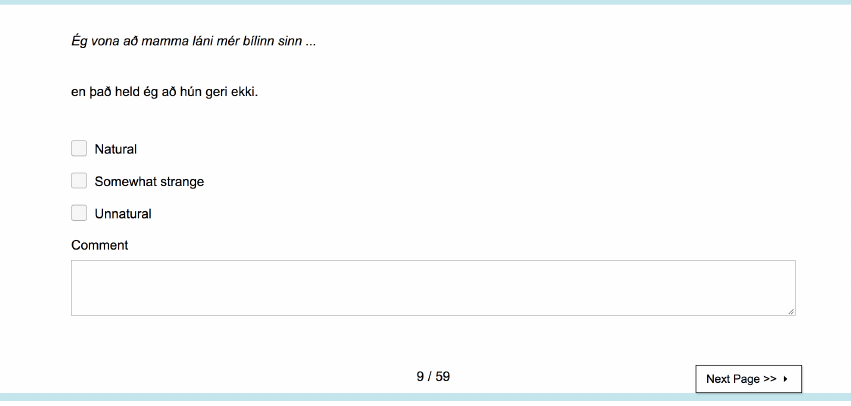
Figure 1. The interface in Sunet